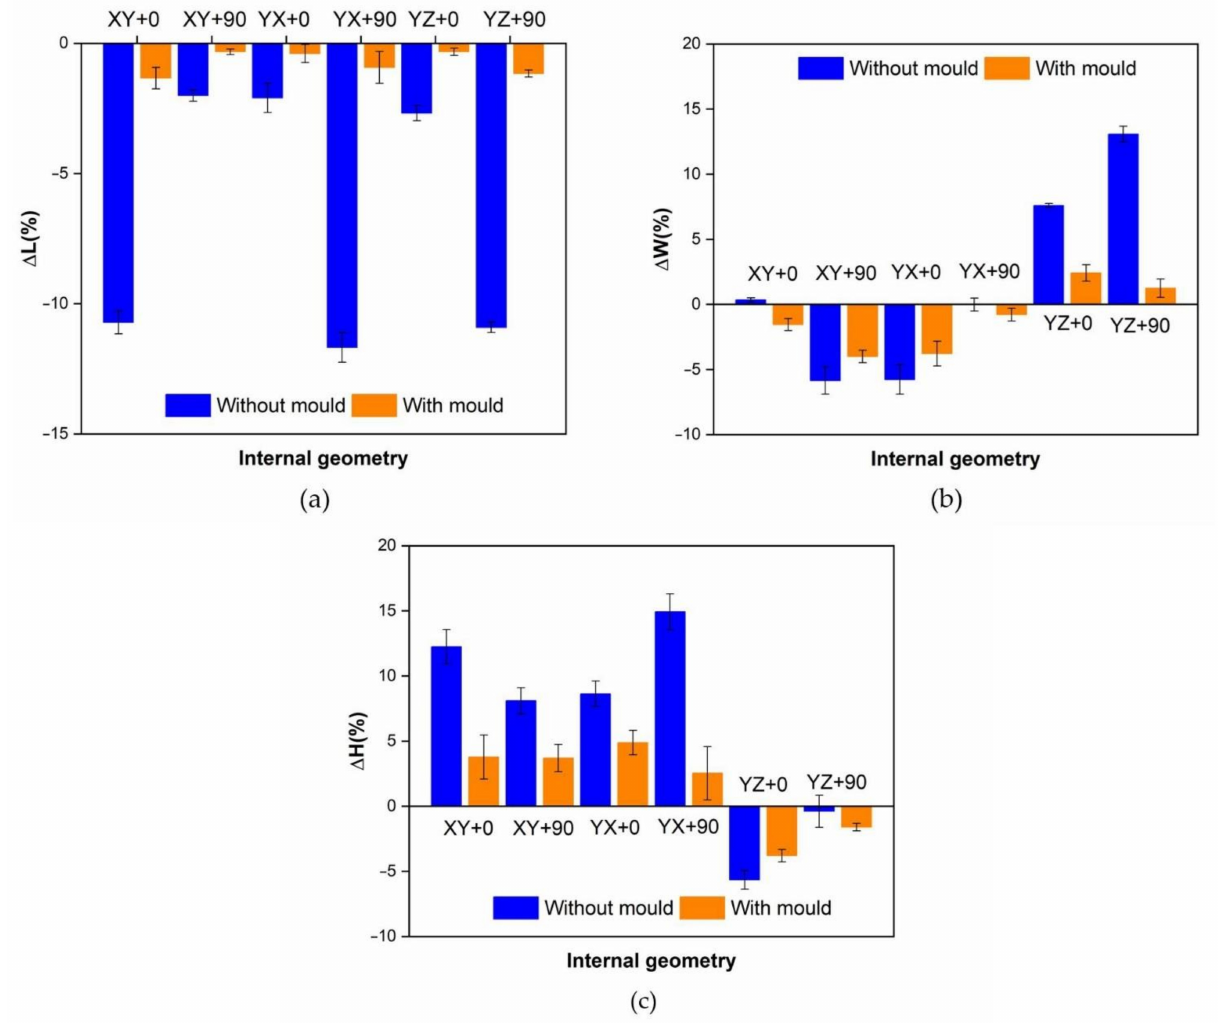
Figure 7. Variations attending to internal geometry and powder mould usage. ( a ) Length variations; ( b ) width variations; ( c ) height